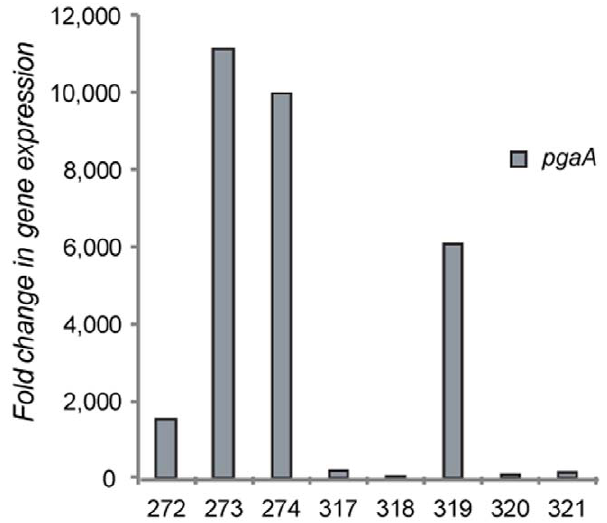
Figure 4. Variation in pgaA expression among mice challenged with E. coli O104:H4 for 13–15 days relative to planktonic growth invitro . The Y-axis represents the fold change in cecal gene expression levels while the x-axis is the mouse identification number.